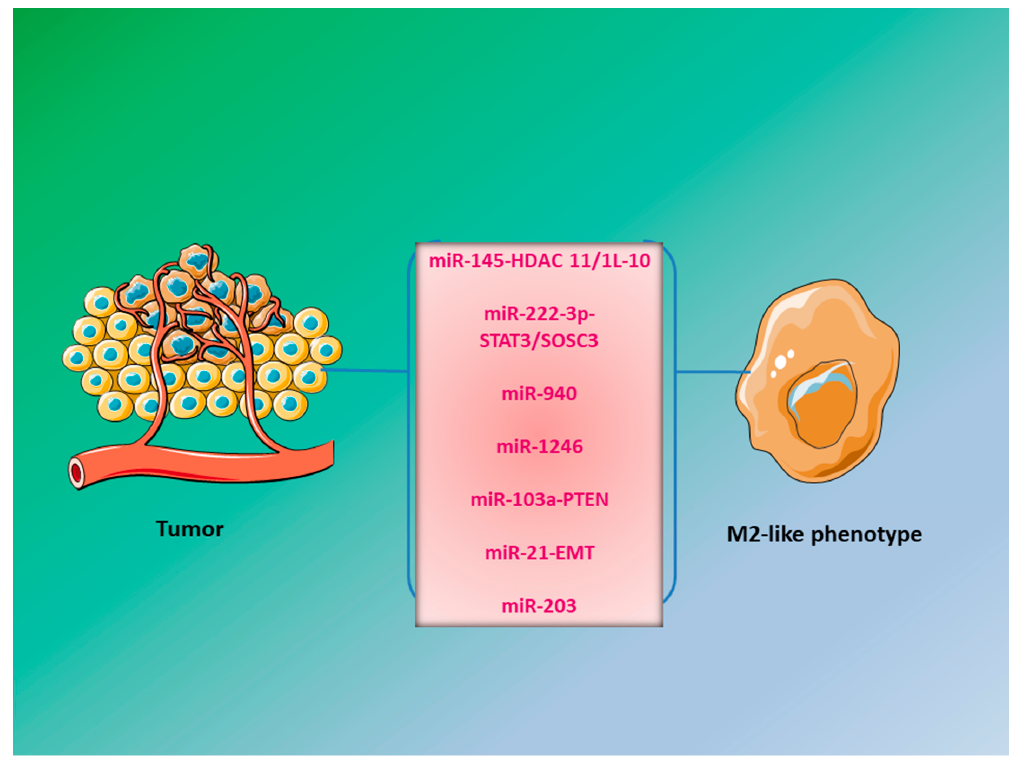
Figure 3. miRNAs secreted from cancer cells promoting the M2-like macrophages.